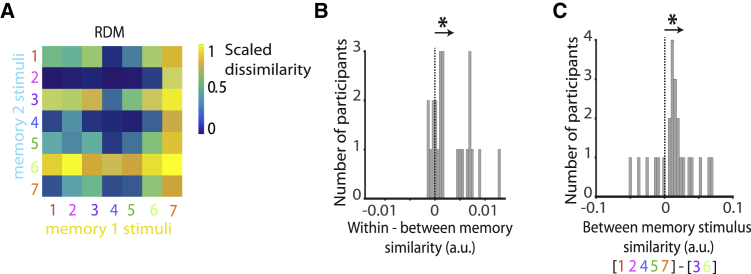
Hippocampal Representations Show Evidence for Contextual Pattern Separation, Organized by Relational OverlapFor each trial in the scan task, the pattern of BOLD activity across voxels was extracted from the hippocampus (Figure 2G), and representational dissimilarity between all trials containing each of the 7 stimuli was assessed using representational similarity analysis (RSA). For example, representations of stimulus 1 in memory 1 included all pairs of stimuli shown on a yellow background that included stimulus 1 (i.e., 1–1, 1–2, … 1–7).(A) Representational dissimilarity matrix (RDM) showing the average representational dissimilarity between stimuli in memory 1 and memory 2, averaged across all participants, rank transformed and scaled into [0–1] for visualization.(B) The RDM for each participant was correlated with a model RDM shown in Figure S2D to test evidence for pattern separation of hippocampal representations by memory. Across participants, significant representational similarity within memory 1/2 versus between memory 1 and memory 2 was observed (Wilcoxon sign rank test: Z23 = 3.34, p = < 0.001), even if stimuli 3 and 6 were excluded (see Figure S2G). Note: the dissimilarity of a trial to itself was excluded from the analysis. “a.u.” refers to “arbitrary units.”(C) The RDM for each participant was correlated with a model RDM shown in Figure S2E to test evidence for increased representational dissimilarity of stimuli that had different relative position across memory 1 and memory 2 (stimuli 3 and 6). Across participants, significantly greater representational dissimilarity between memory 1 and memory 2 was observed for stimuli 3 and 6 compared to all other stimuli (Wilcoxon sign rank test: Z23 = 2.26, p = 0.024). “a.u.” refers to “arbitrary units.”